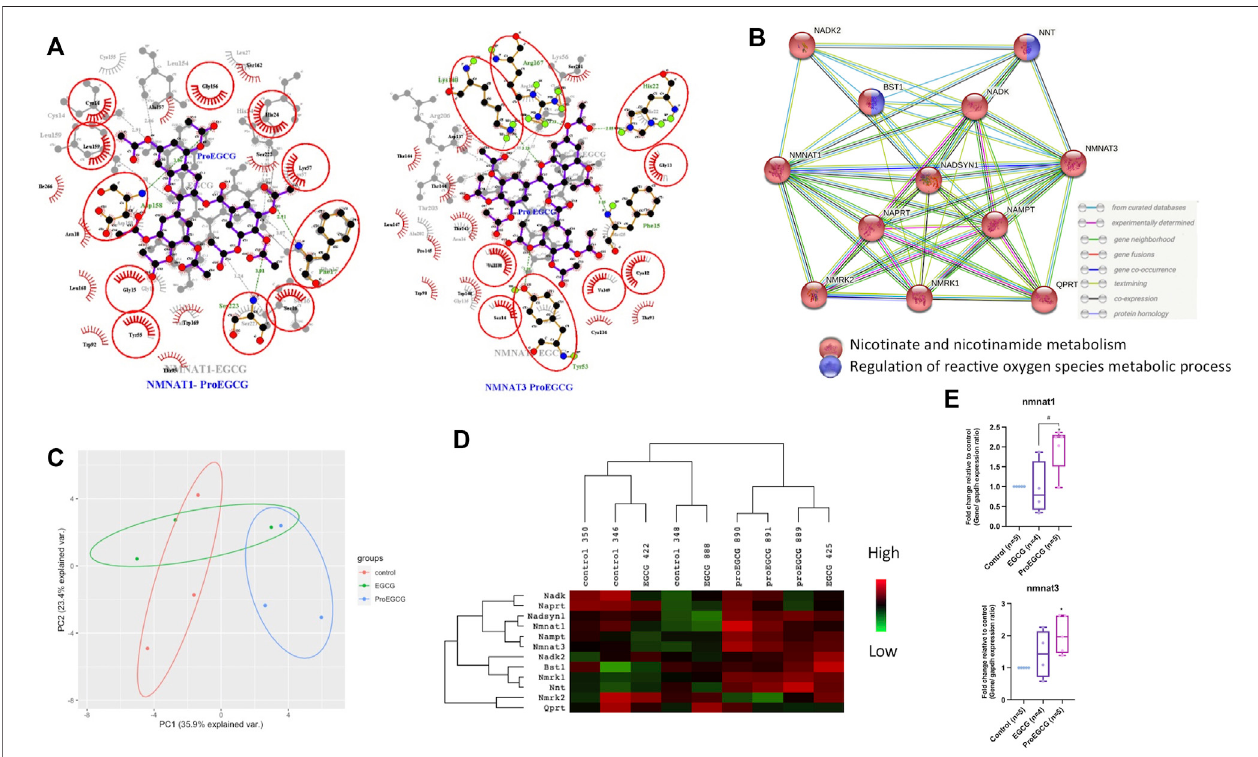
FIGURE5| Networkanalysis. (A) ligplotshowstheinteraction analysisofstructures ofprotein-ligandsbindingsitesina2Dinteractionschemeareshown.Overlap of two complexes NMNAT1-Ligands (left) and NMNAT3-Ligands (right) as shown. Residues that are involved in both complexes are denoted in red circles. Pro EGCG complexes, labelled in blue colour are on top and EGCG complexes, labelled in grey colour are on bottom of each fi gure. (B) Protein-Protein interaction network by STRING showing interaction of NMNTA1 and NMNAT3 with other proteins. (C) Principal component analysis score plot with the microarray expression pro fi les in different treatments ( n (cid:1) 3). (D) Heatmap shows the downstream proteins expression levels in different treatments of endometriosis mice model in microarray analysis ( n (cid:1) 3). Heatmap was generated and presented by java Treeview. Rows and columns are mean-centered, with relative abundance represented by color (green, lower abundance; red, higher abundance). (E) qRT-PCR analysis was conducted by measuring the fold change of gene expression levels in lesions of endometriosis mice model after EGCG or ProEGCG treatments. Gene levels were normalized relative to control and GAPDH as housekeeping gene. The fold change between groups were comparedbywhiskerplot( n (cid:1) 4 – 5).Topandbottomboxedgesrepresentedthethirdand fi